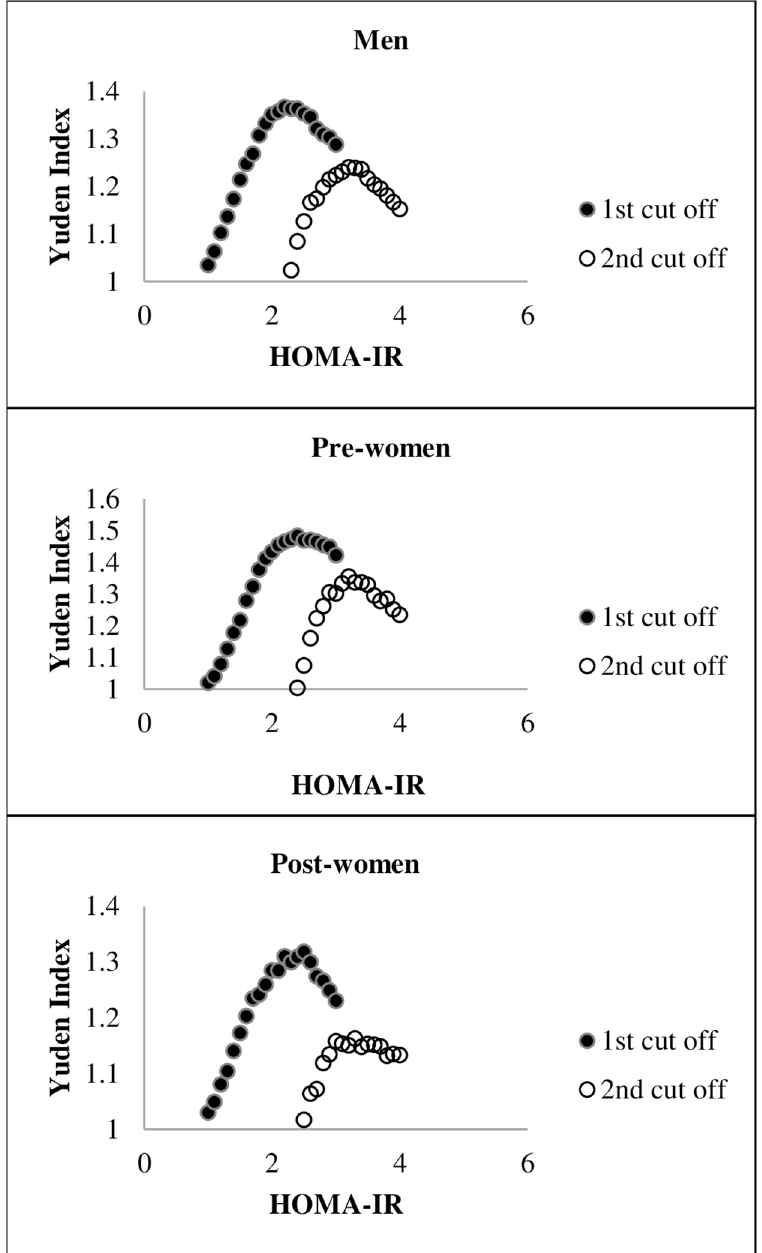
Fig 2. First and second cut-off values of HOMA-IR in men, premenopausal women and postmenopausal women. The Youden index, calculated as (sensitivity + specificity − 1) was estimated to determine optimal cut- off values. After those subjects with a HOMA-IR lower than the first HOMA-IR cut-off value had been excluded, the data were recalculated to obtain the second cut-off. The first cut-off values in men, premenopausal women, and postmenopausal women were 2.23 (AUC 0.75, sensitivity 70.6%, specificity 66.9%), 2.39 (AUC 0.82, sensitivity 72.3%, specificity 76.4%), and 2.48 (AUC 0.71, sensitivity 51.9%, specificity 80.2%). The second cut- off values in men, premenopausal women, and postmenopausal women were 3.23 (AUC 0.65, sensitivity 48.2%, specificity 76.5%), 3.20 (AUC 0.71, sensitivity 64.8%, specificity 70.8%), and 3.28 (AUC 0.61, sensitivity 45.8%, specificity 71.6%). HOMA-IR: homeostasis model assessment of insulin resistance; Pre-women: premenopausal women; Post-women: postmenopausal women.